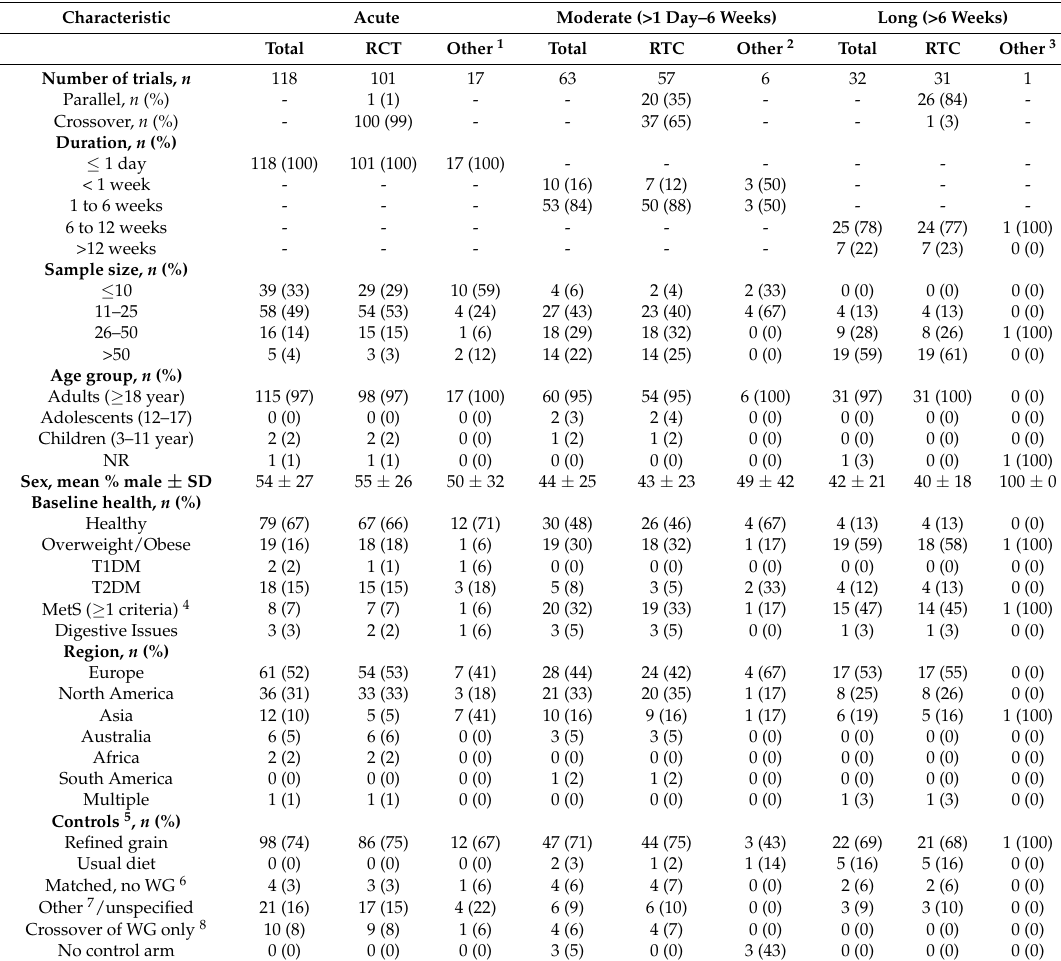
Table 1. Study design characteristics of whole grain intervention trials in humans, organized by trial